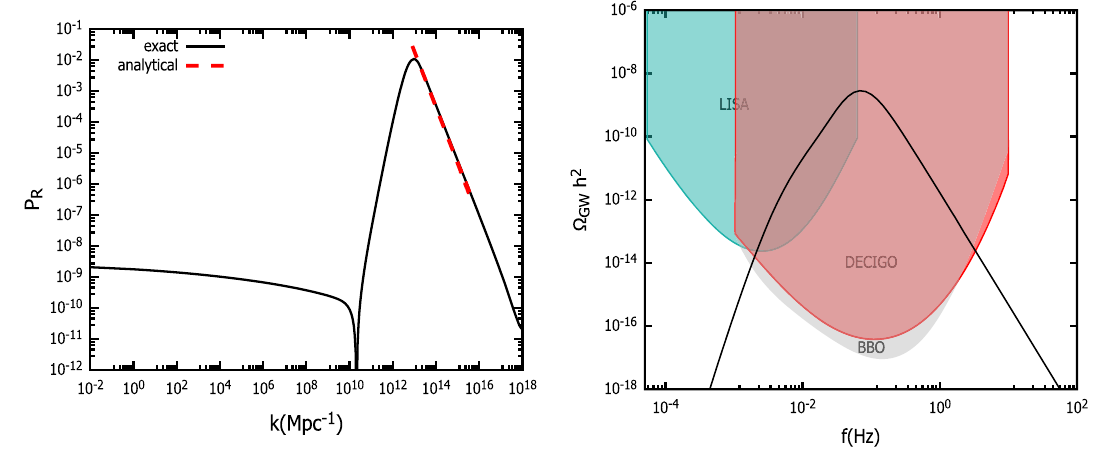
Fig. 2 The power spectrum (left) with solid line (numerical) and with dashed (analytical from Eq. 2.34). The density of stochastic GWs (right). Both plots are for the case of modifying Wess–Zumino superpotential. We choose λ/μ = 1 / 3, c 1 = 1 . 9, c 2 = − 0 . 73 and b 1 = 3 . 9615